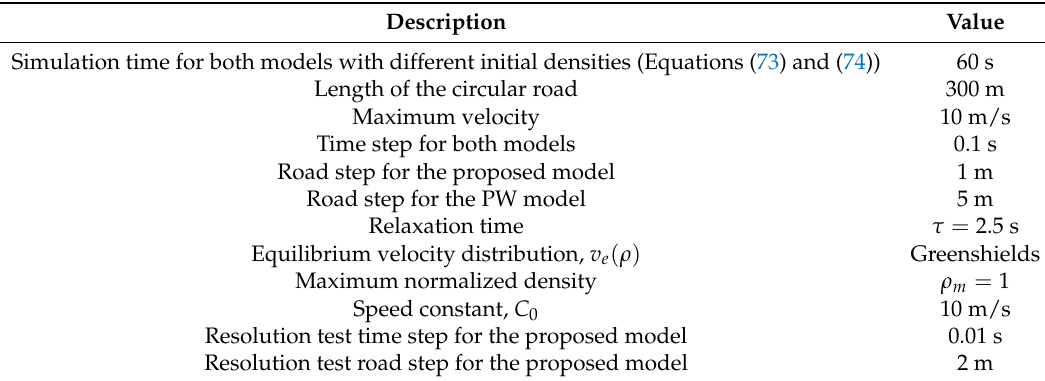
Table 2. Simulation parameters.